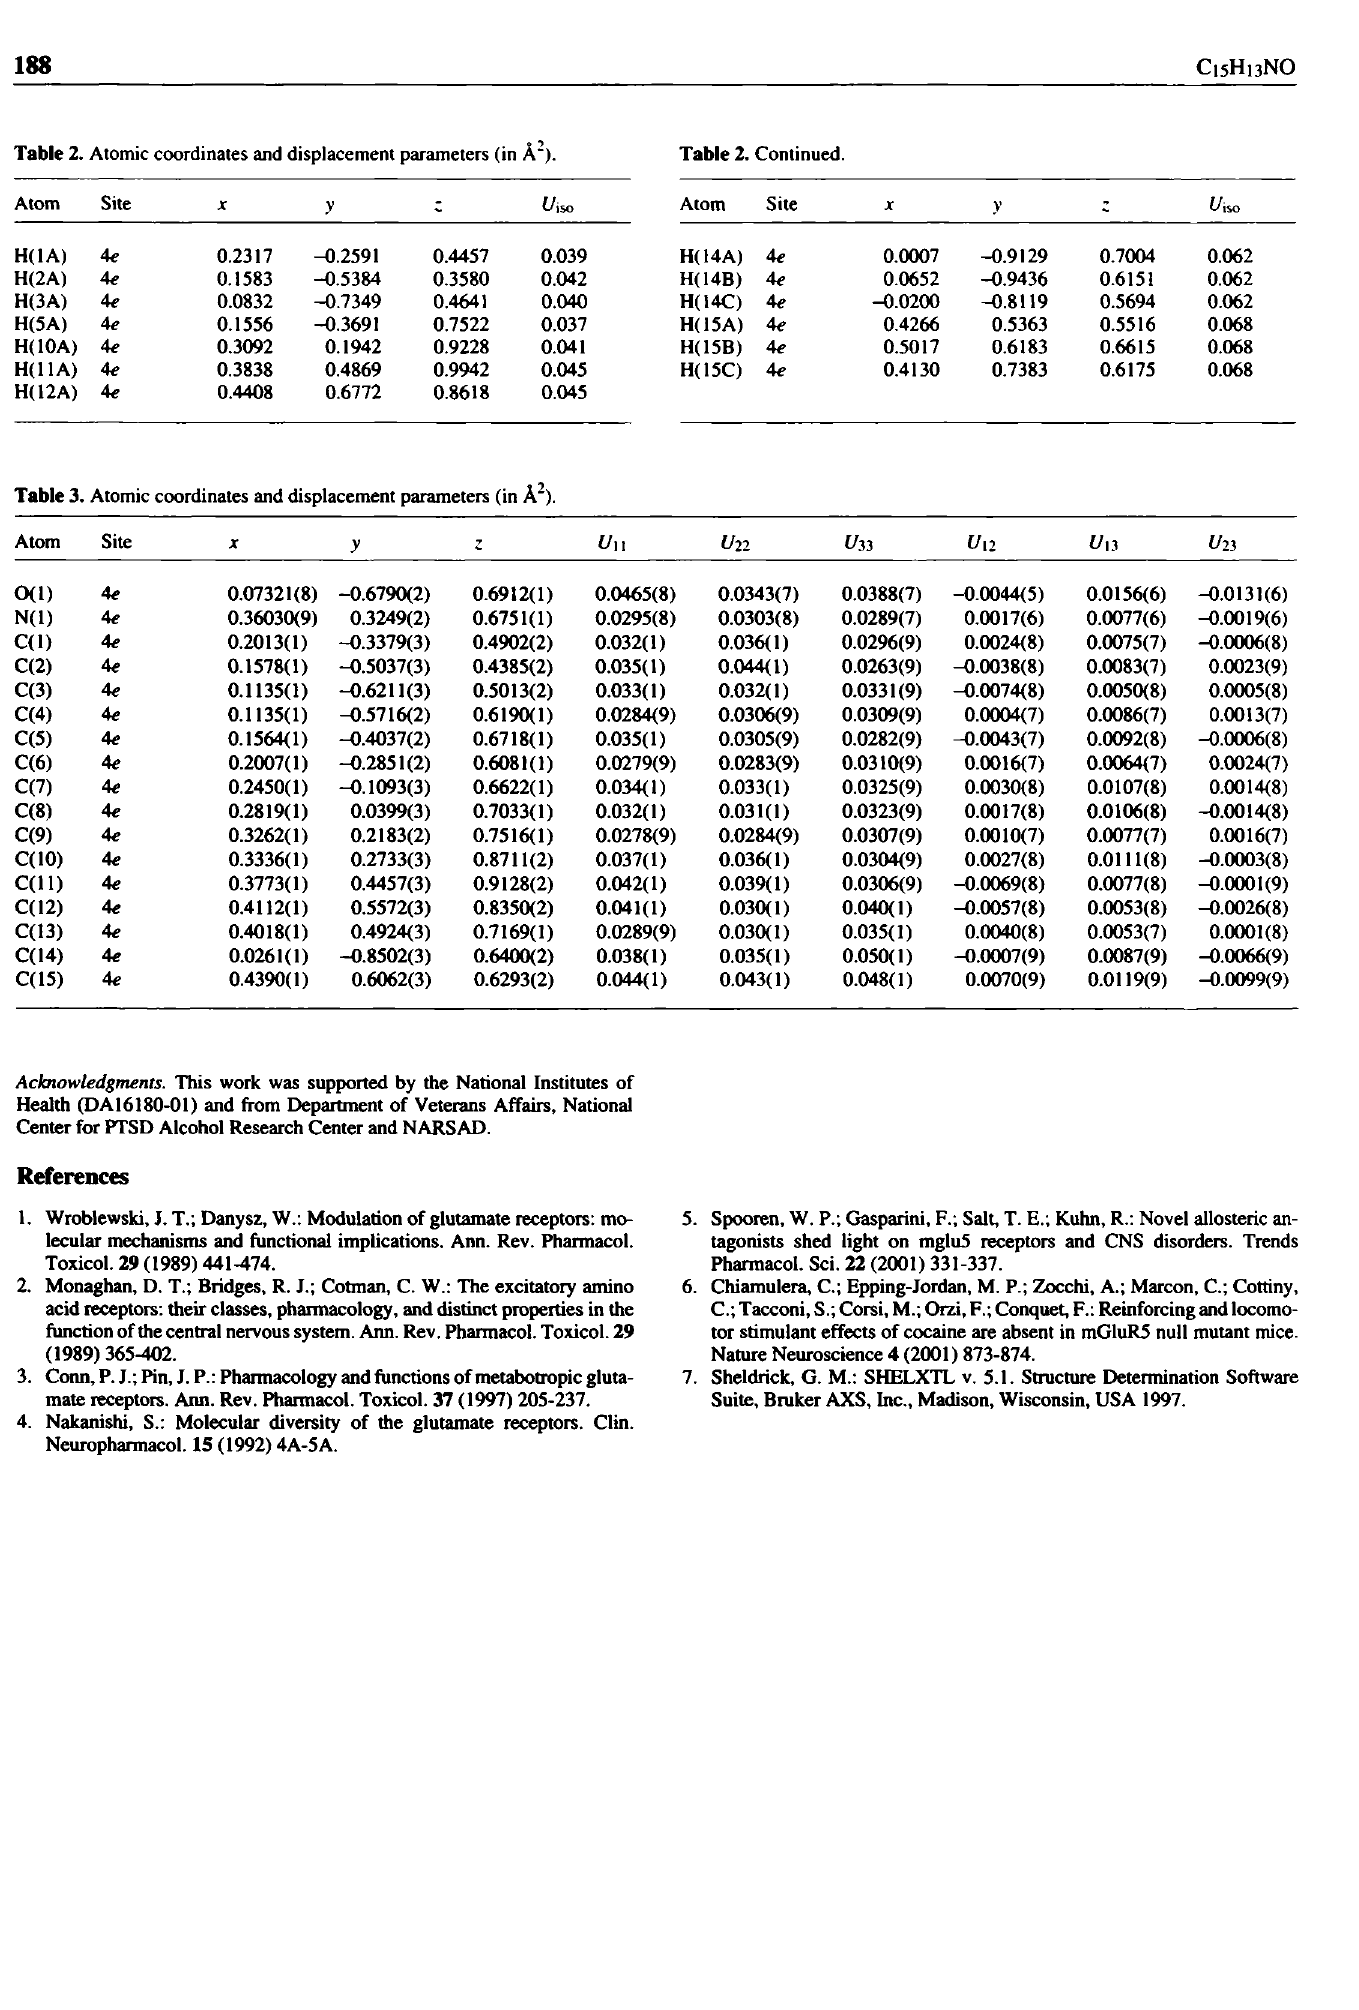
Table 2. Atomic coordinates and displacement parameters (in Â 2 ).